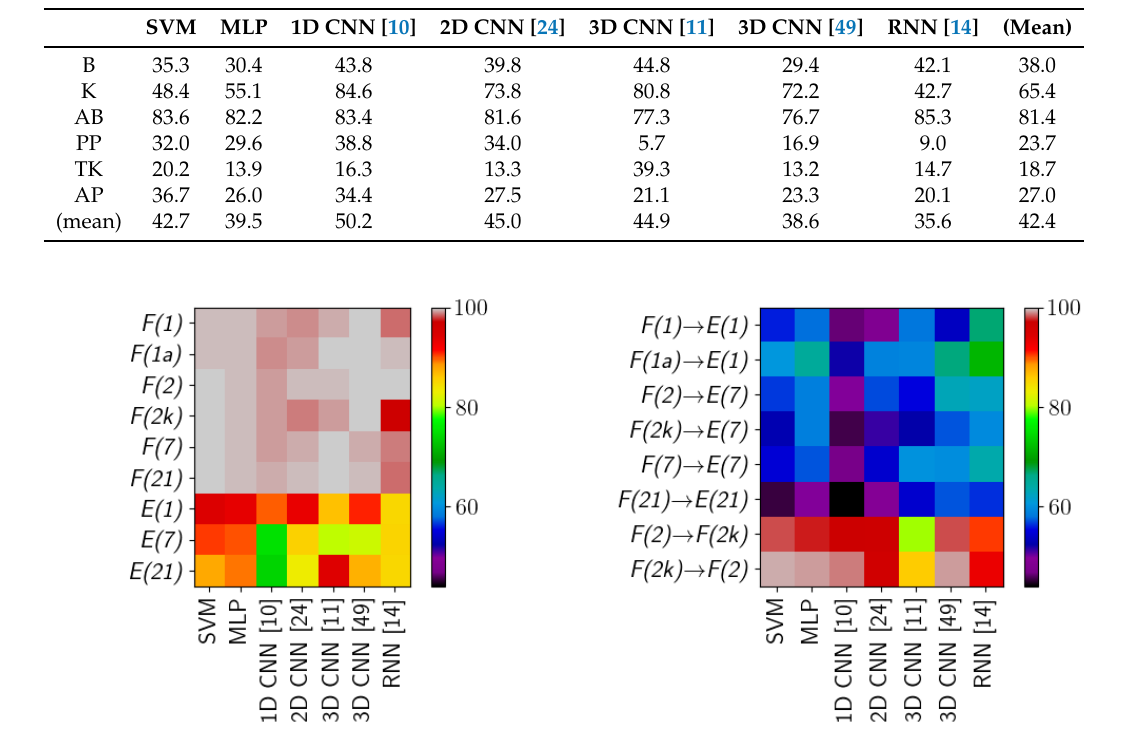
Figure 11. Graphical visualization of results from transductive (HTC, Table 1) and inductive (HIC, Table 2) scenario. The presentation is based on the Overall Accuracy